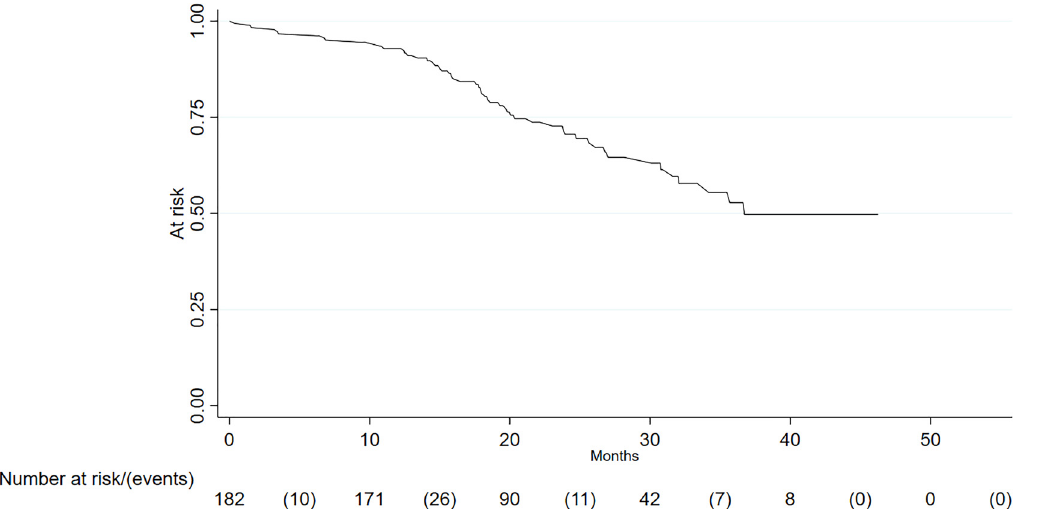
Figure 1: Overall survival.